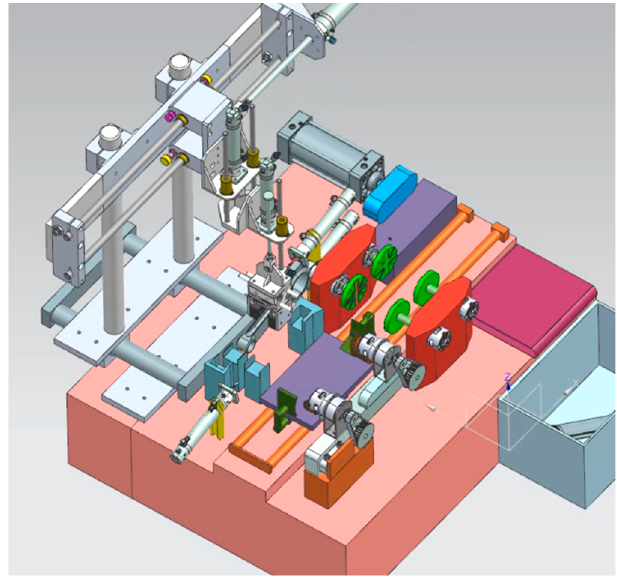
Figure 22. The normal operation state of the first part of the processing area.